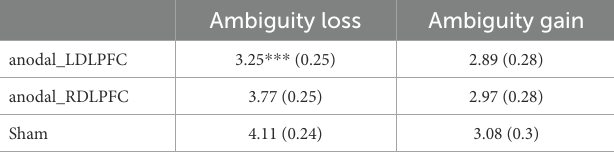
TABLE 1 Mean (M) and standard error (SE) of the dataset about the degree of attitudes toward ambiguity loss/gain under stimulation conditions.